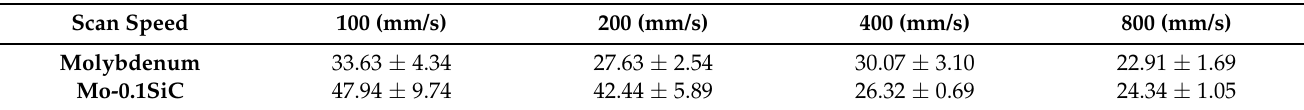
Table 2. Average grain diameters ( µ m) for the pure molybdenum and Mo-0.1SiC specimens corre- sponding to Figures 4 and 5,